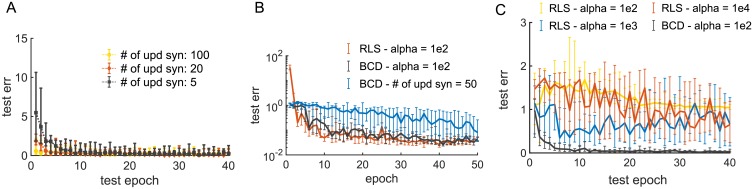
Some comparisons with RLS.A: Test error during training as a function of testing epoch for balanced networks of N = 200 LIF units trained on the oscillatory task in Fig 2A with BCD (α = 0.05). Each curve shows the results obtained when only a random subset of the incoming synapses onto each neuron gets updated. Networks were trained with feedback stabilization. Recurrent synaptic weights were updated every 20 time steps. The network was tested each 5 periods of the oscillations (1 sec). Each point is the median over 20 random initialization of both student and teacher networks. Bars represent 90% and 10% percentile. B: Test error as a function of training epoch for networks of N = 1000 Quadratic Integrate and Fire (QIF) neurons (for details see [27]) trained to reproduce their innate currents (task in Fig 6B) using Recursive Least Square or BCD. For both algorithms, recurrent synaptic weights were trained once each 25 time-steps (50 ms). Output weights were trained at each time-step via RLS. No feedback stabilization was employed in conjunction with BCD. For comparison with RLS, we employed a large value of α in BCD and did not normalize the first term of Eq (8) by trun, both in panel B and C. Parameters for QIF neurons: τm = 10 ms, τs = 100 ms, (similar to [27]), τref = 2 ms, dt = 2 ms. C: Test error during training as a function of testing epoch for balanced networks of N = 200 LIF units trained on the oscillatory task in panel A, employing RLS with different values of the regularization parameter α. Results for BCD are shown for reference. The network was tested each 5 periods of the oscillations (1 sec). Each point is the median over 20 random initialization of both student and teacher networks. Bars represent 75% and 25% percentile.